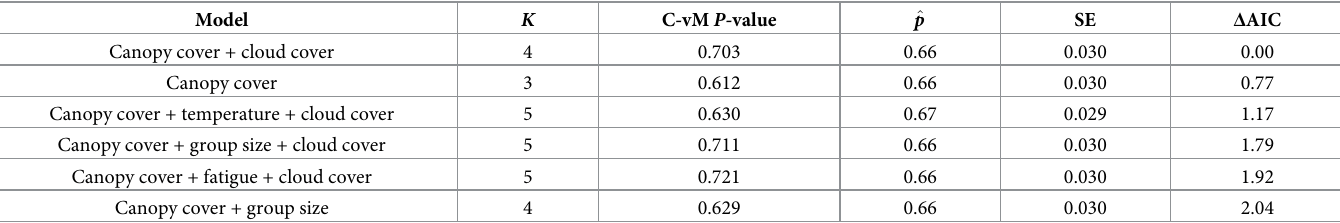
Table 1. Summary of the top 6 candidate detection function models with hazard rate key functions for white-tailed deer in the Adirondack Park, 2016. Indicated for each model are the model covariates, number of estimated parameters ( K ), Cramer von Miser goodness of fit P -value, average probability of detection ( ^ p ) with standard error (SE), and Δ AIC comparing models.